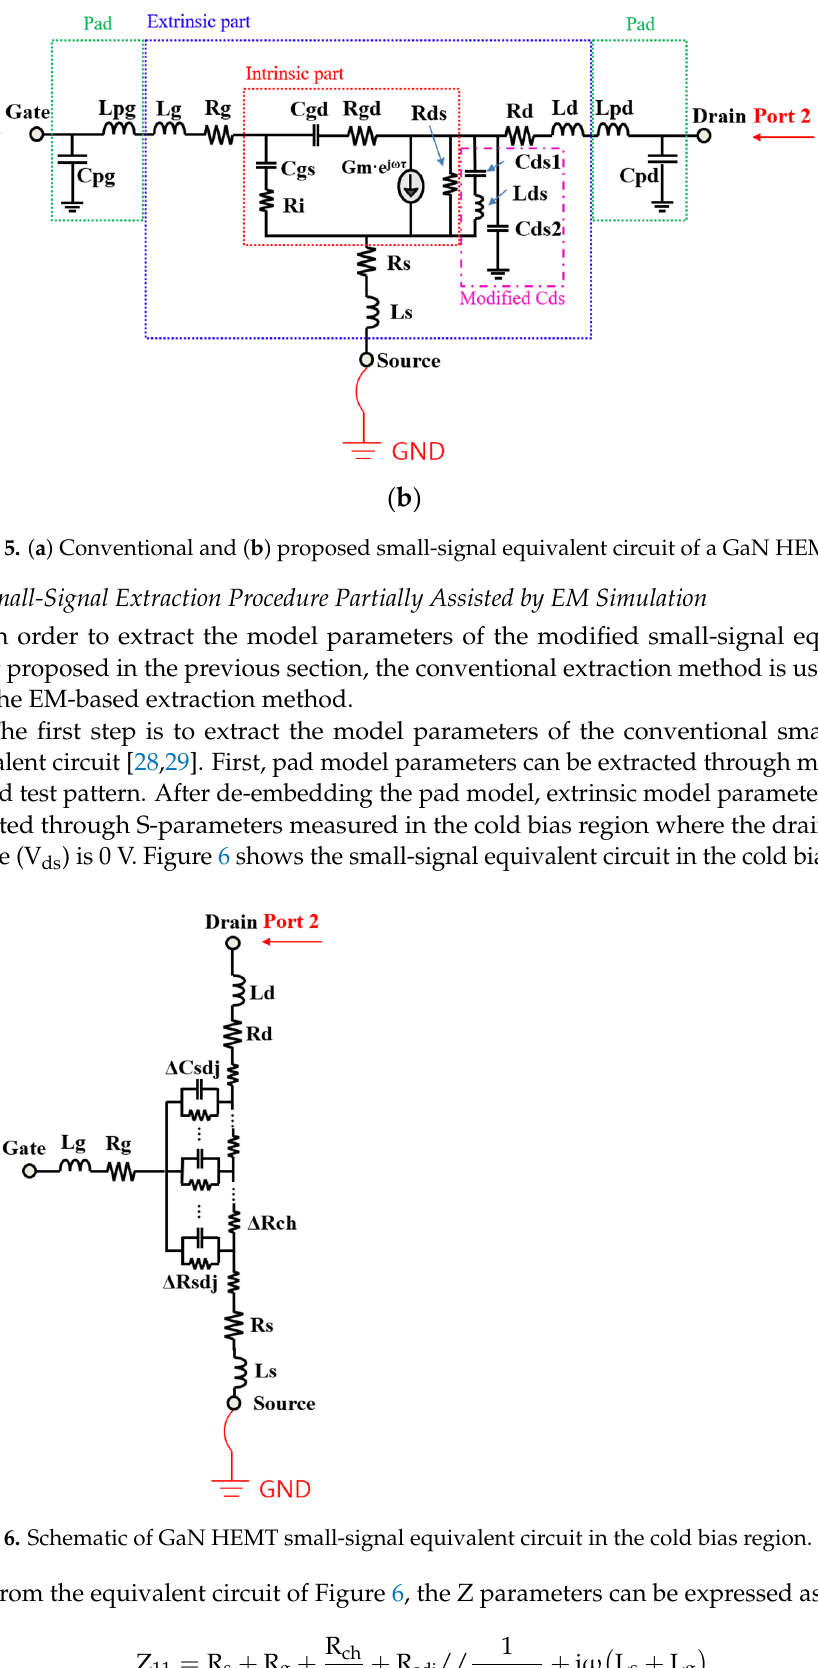
Figure 5. ( a ) Conventional and ( b ) proposed small-signal equivalent circuit of a GaN HEMT.